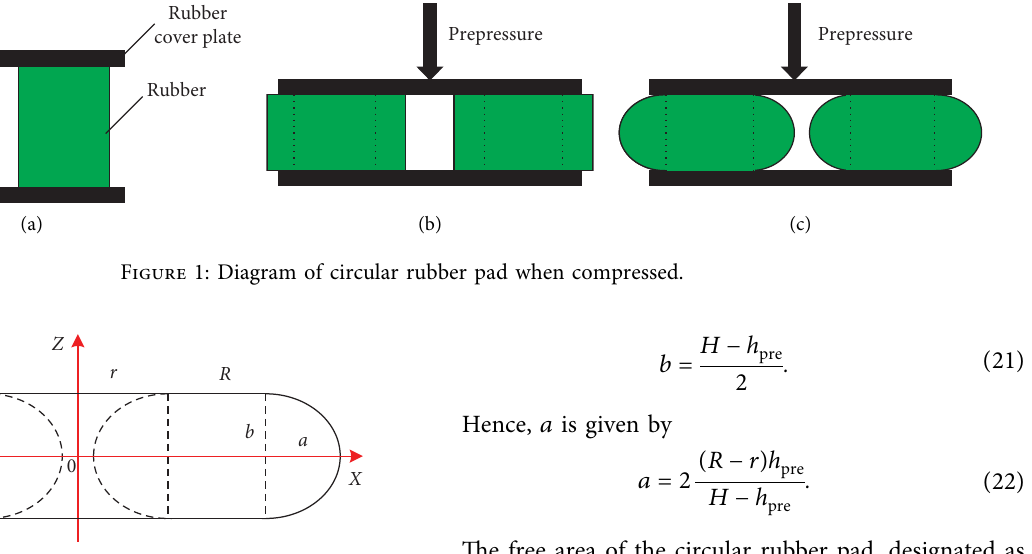
Figure 2: Diagram of geometric contour of circular rubber pad when elliptical shape is